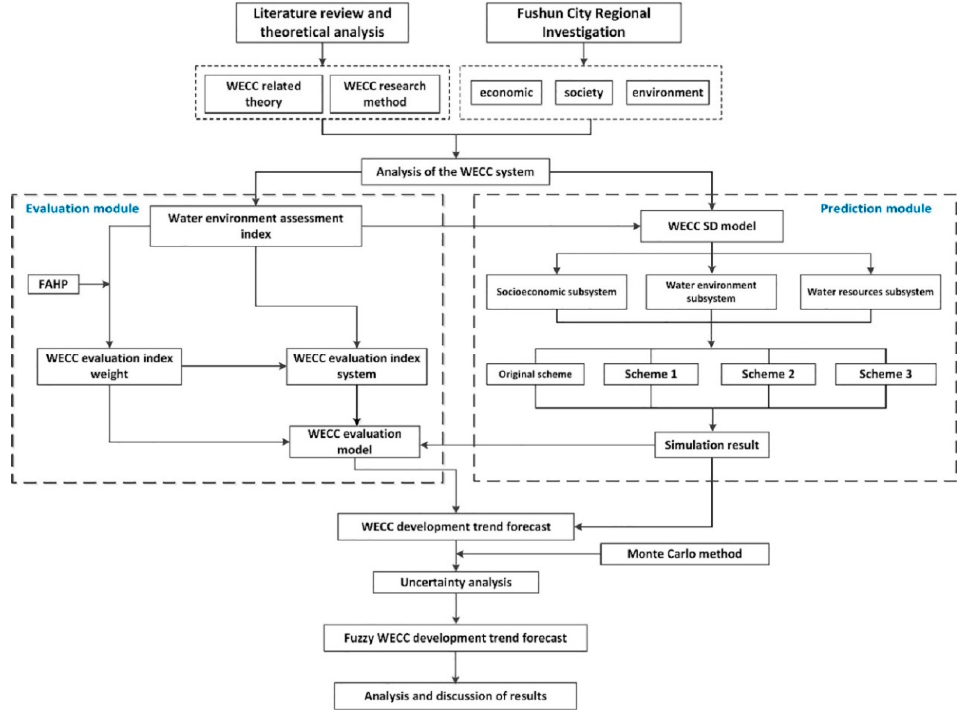
Figure 3. Technological route map.